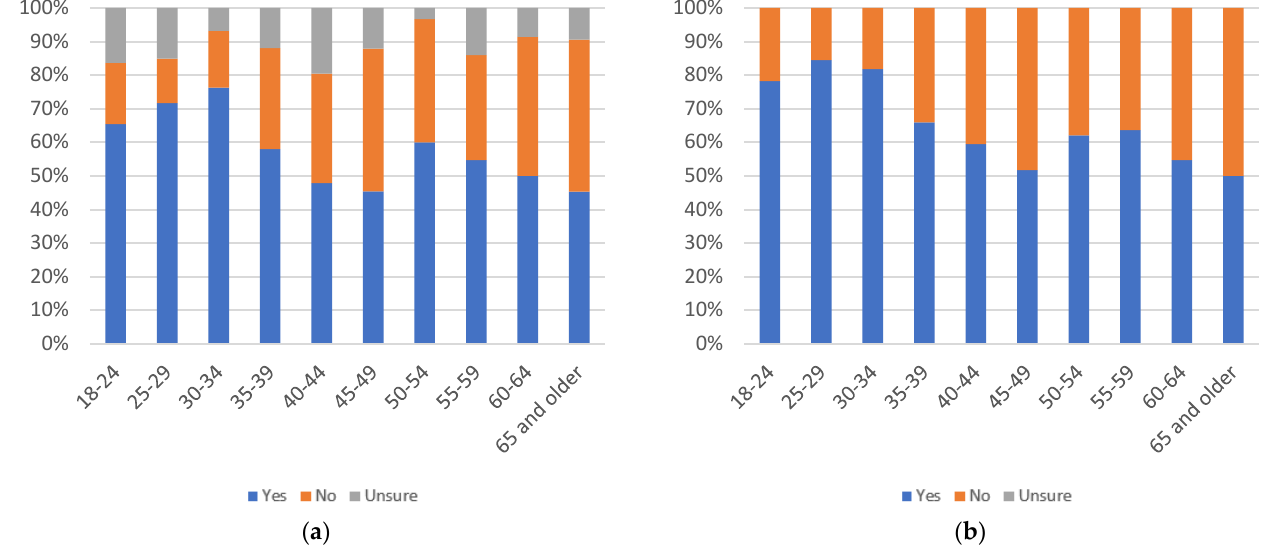
Figure 101. Label helpfulness, by age group: ( a ) with uncertain respondents (left) and ( b ) without uncertain respondents (right).